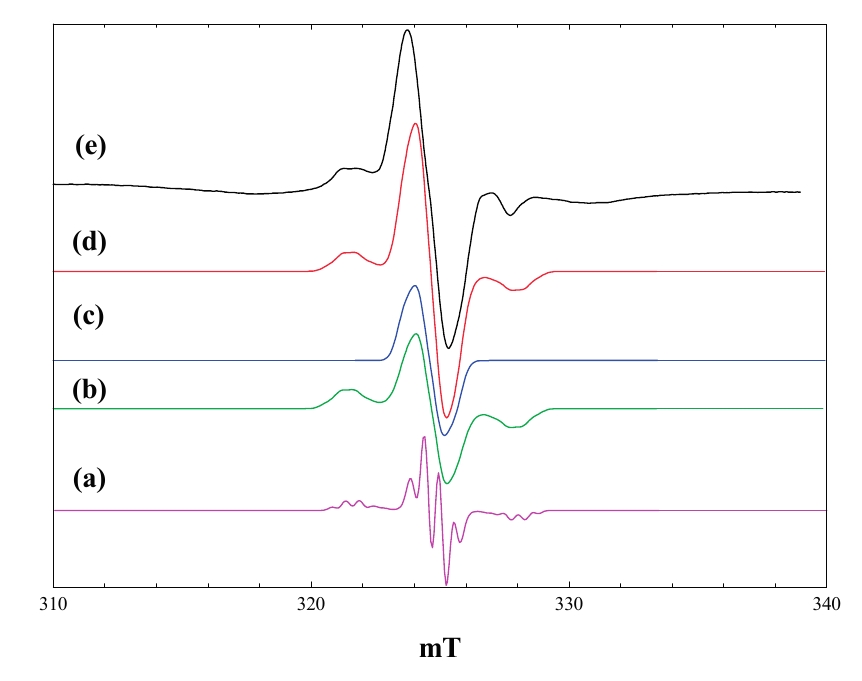
Figure 8. Simulation of the observed spectrum obtained during irradiation of P25 titania in an equimolar mixture of maleimide and phenoxyacetic acid in acetonitrile with high intensity broad-band light at 4 K. (a), Simulation of the phenoxymethyl radical using the parameters described in the text and Gaussian line widths of 0.3 mT (parallel) and 0.5 mT (perpendicular); (b), Gaussian line widths of 0.5 mT (parallel) and 1.0 mT (perpendicular); (c), simulation